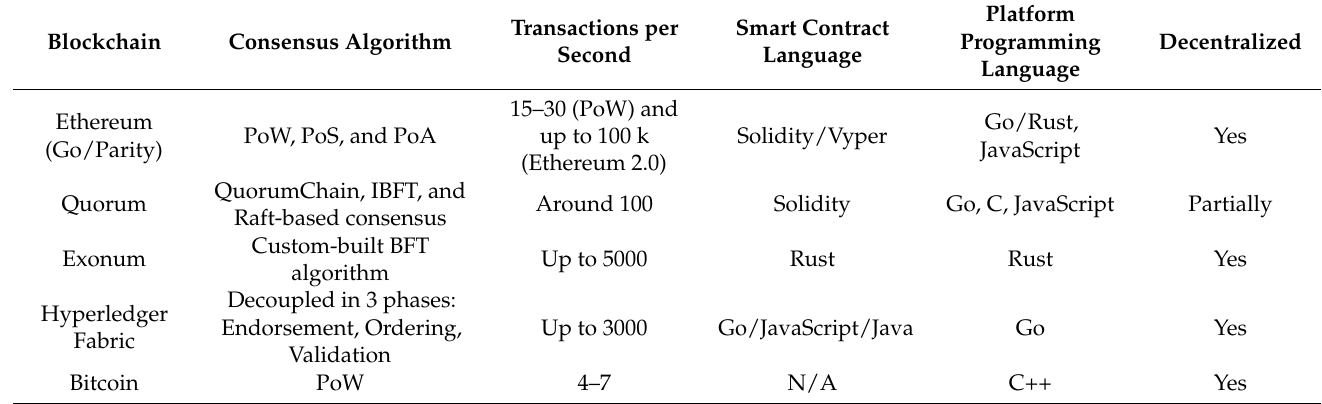
Table 2. Blockchains Platform Comparison.